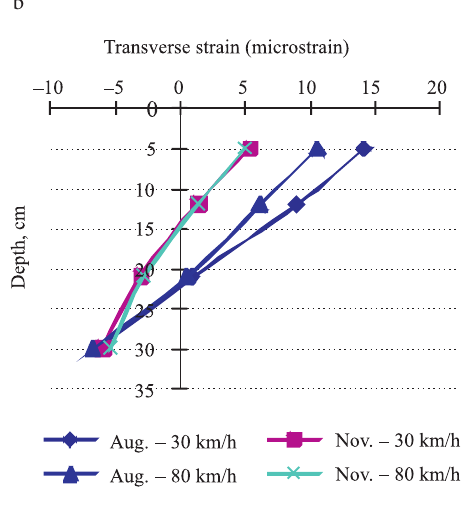
Fig. 2. Measured transverse strain for: a – ASG 6; b –